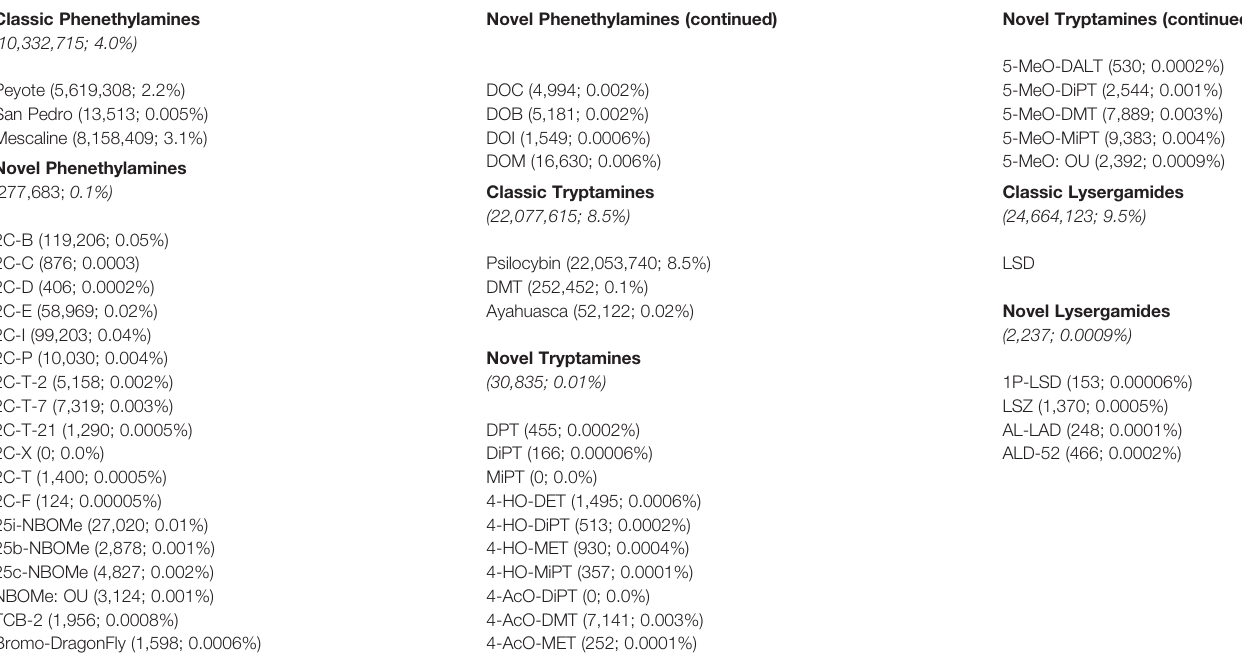
TABLE 2 | Weighted frequencies of lifetime use of each psychedelic category and lifetime use of speci fi c substances within each of these categories from the 2008 – 2017 NSDUH. Classic Phenethylamines (10,332,715;